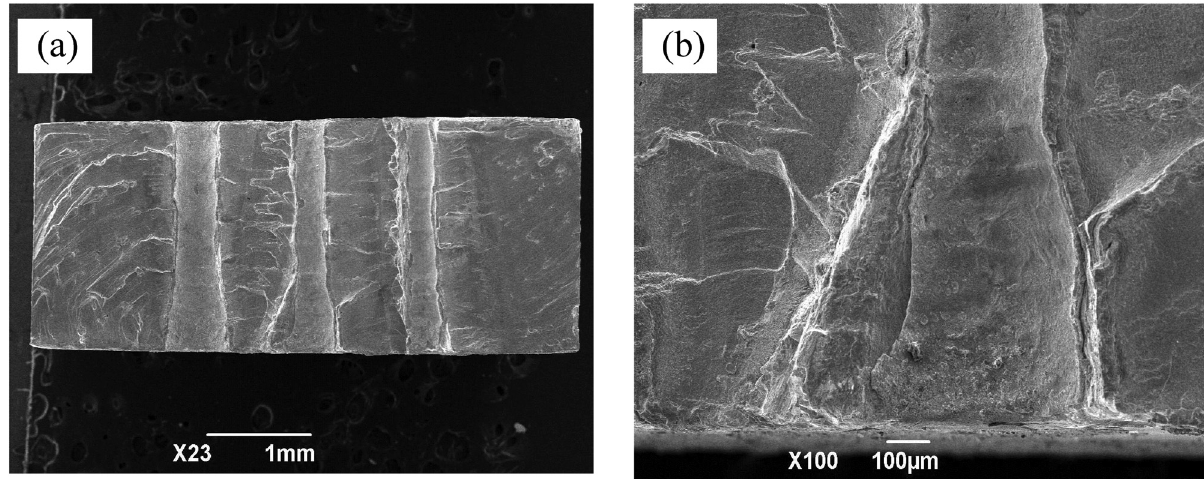
Figure 9: Fracture morphology of ESM: ( a ) Macroscopic fracture morphology, ( b ) Microscopic fracture